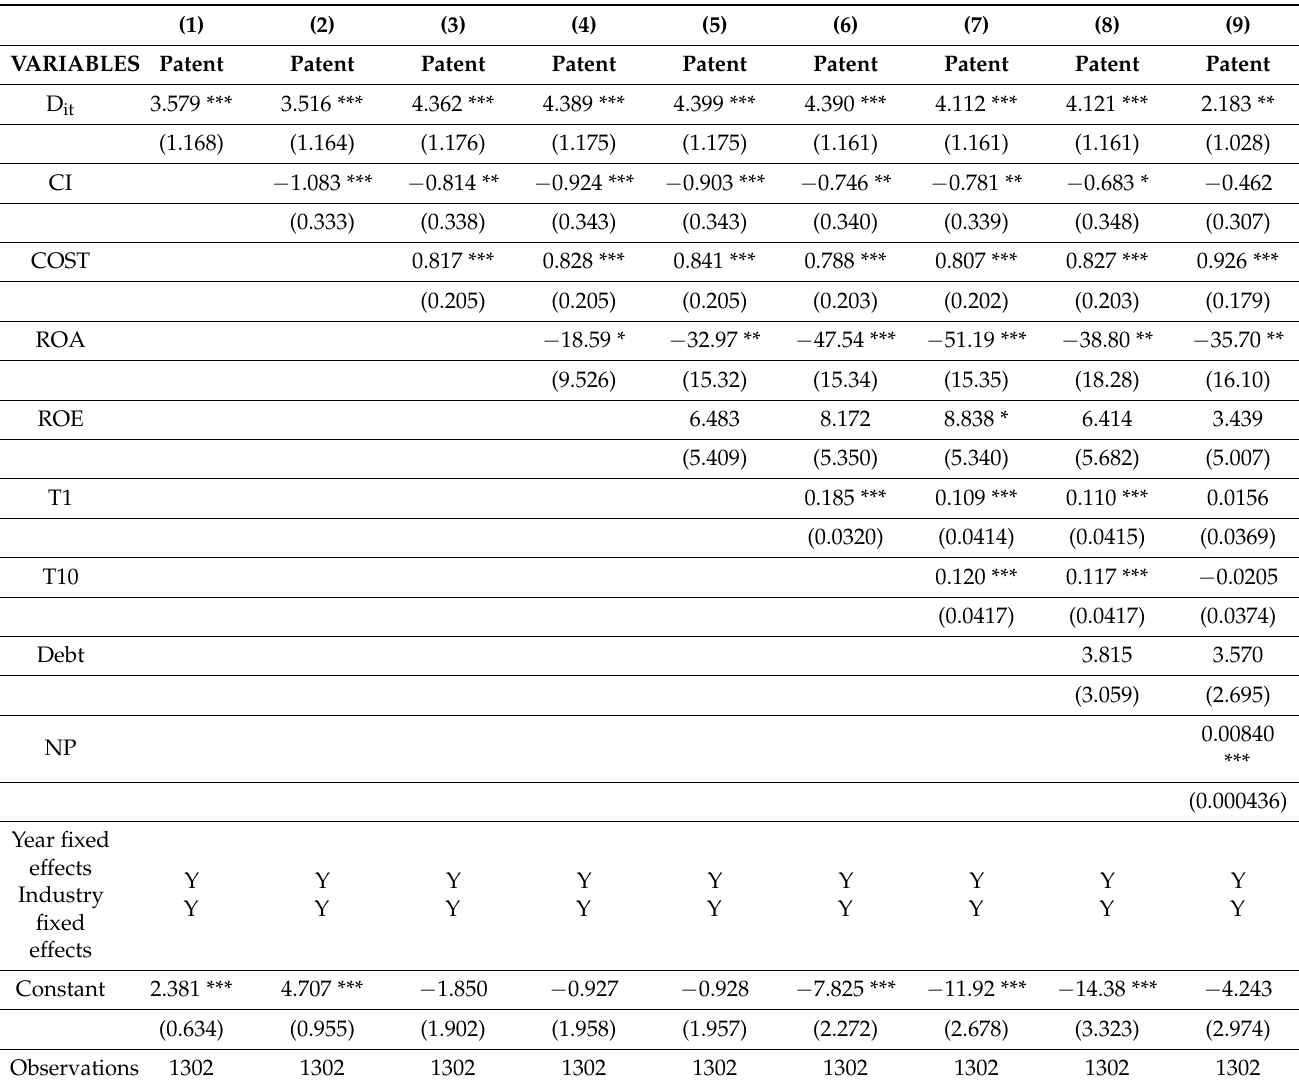
Table 4. Benchmark regression